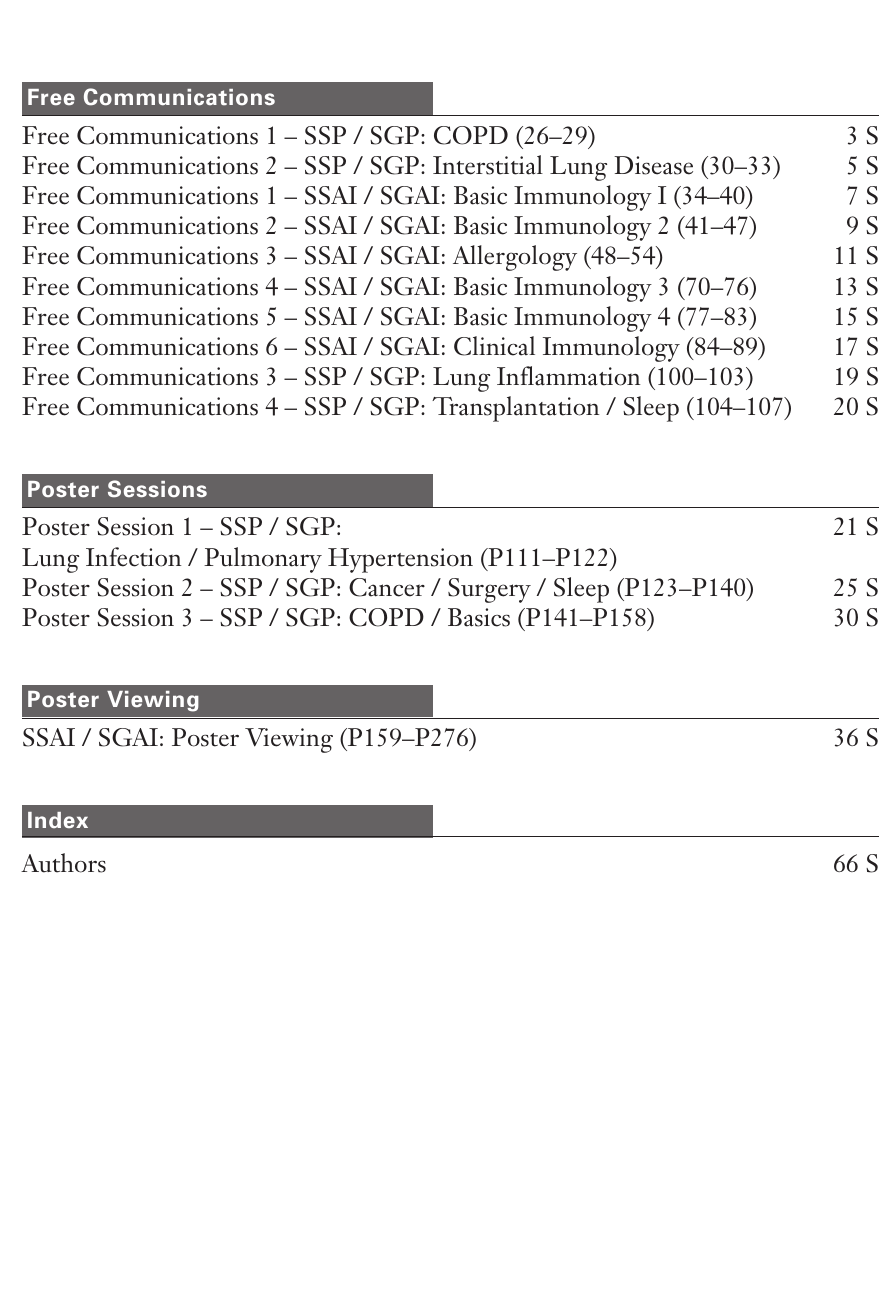
Table of contents SWISS MED WKLY 2008;138(Suppl 163) ·